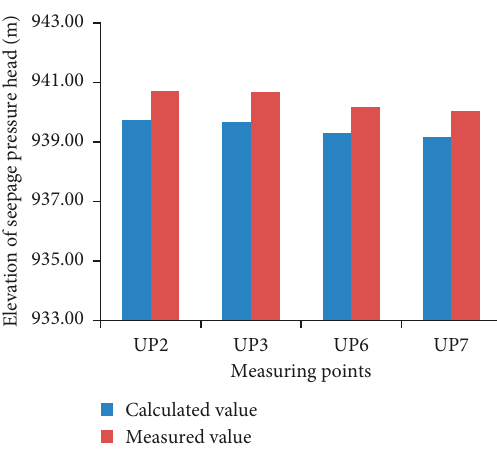
Figure 17: Comparison of calculated value and measured value in flood season.